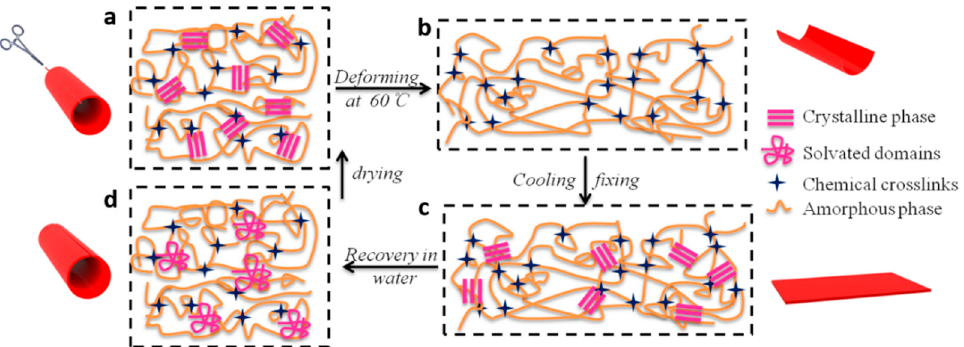
Figure 8. Illustration showing the mechanism underlying the shape-memory transition of PHP tubes ( a ) the dry original shape, ( b ) the heating and deforming state, ( c ) the temporary shape and ( d ) the wet original shape